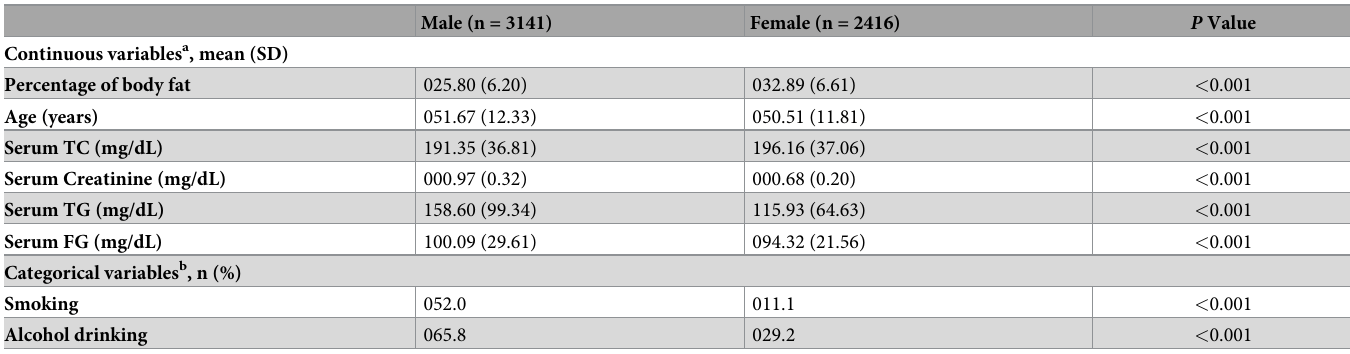
Table 1. Characteristics of study participants.